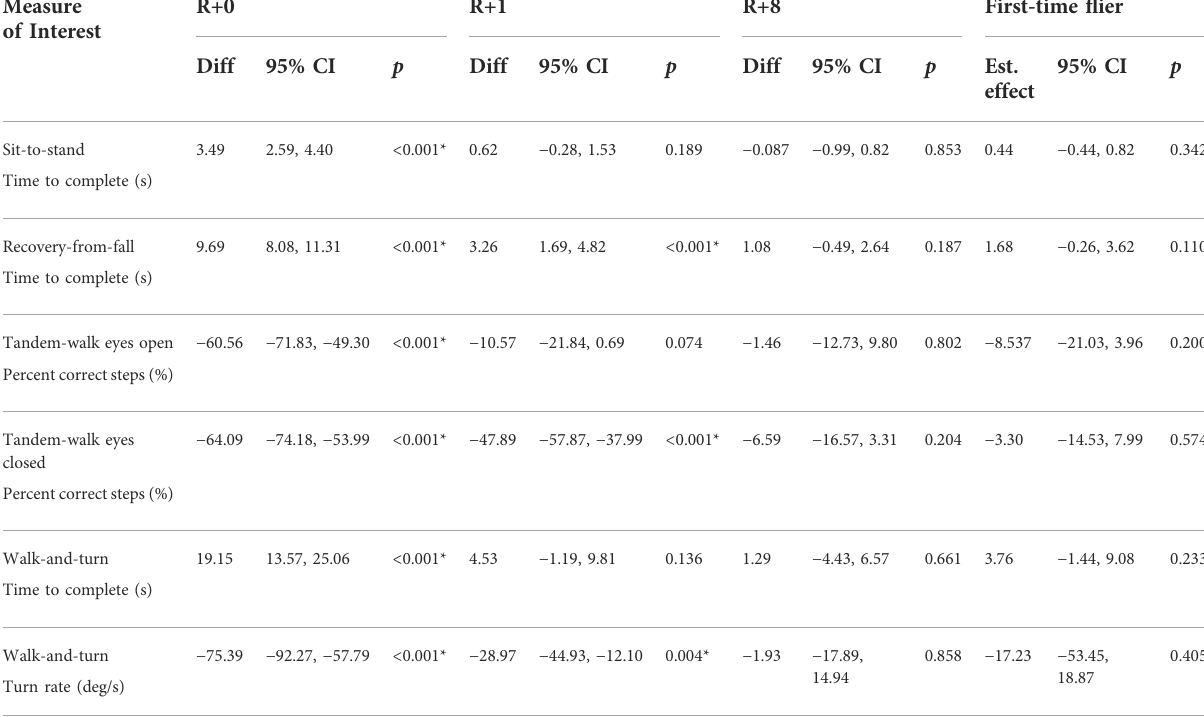
TABLE 1 Pairwise difference between return day measures (R+0, R+1, R+8) and pre fl ight measures, and estimated effects for fi rst-time fl yers versus experienced fl yers. R+0 includes measures collected up to 24 h after landing; R+1 includes measures collected between 24 and 48 h after landing, and R+8 includes measures collected from 3 to 11 days after landing. CI: 95% con fi dence interval of effect (min, max); * p < 0.05 relative to pre fl ight values; EO, Eyes Open; EC, Eyes Closed. Measure of